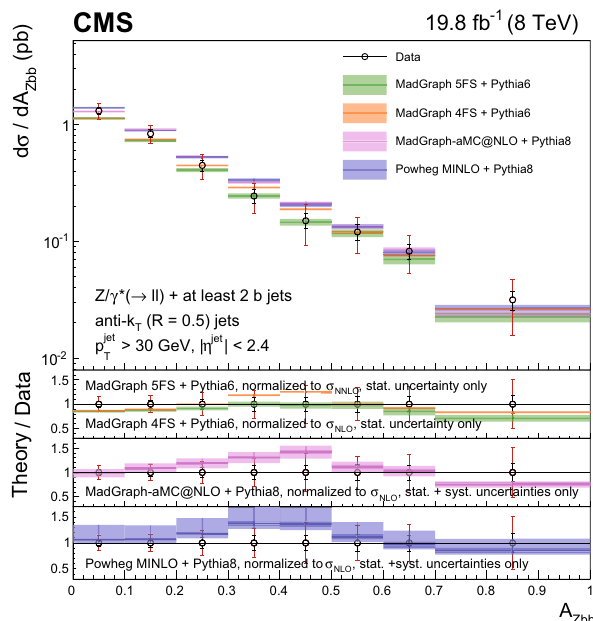
Fig. 17 Differential fiducial cross section for Z(2b) production as a function of A Zbb , compared with the MadGraph 5FS, MadGraph 4FS, MadGraph5 _a MC@NLO , and powheg minlo theoretical pre- dictions ( shaded bands ), normalized to the theoretical cross sections describedinthetext.Foreachdatapointthestatisticalandthetotal(sum in quadrature of statistical and systematic) uncertainties are represented by the double error bar . The width of the shaded bands represents the uncertainty in the theoretical predictions, and, for NLO calculations, theoretical systematic uncertainties are added in the ratio plots with the inner darker area representing the statistical component